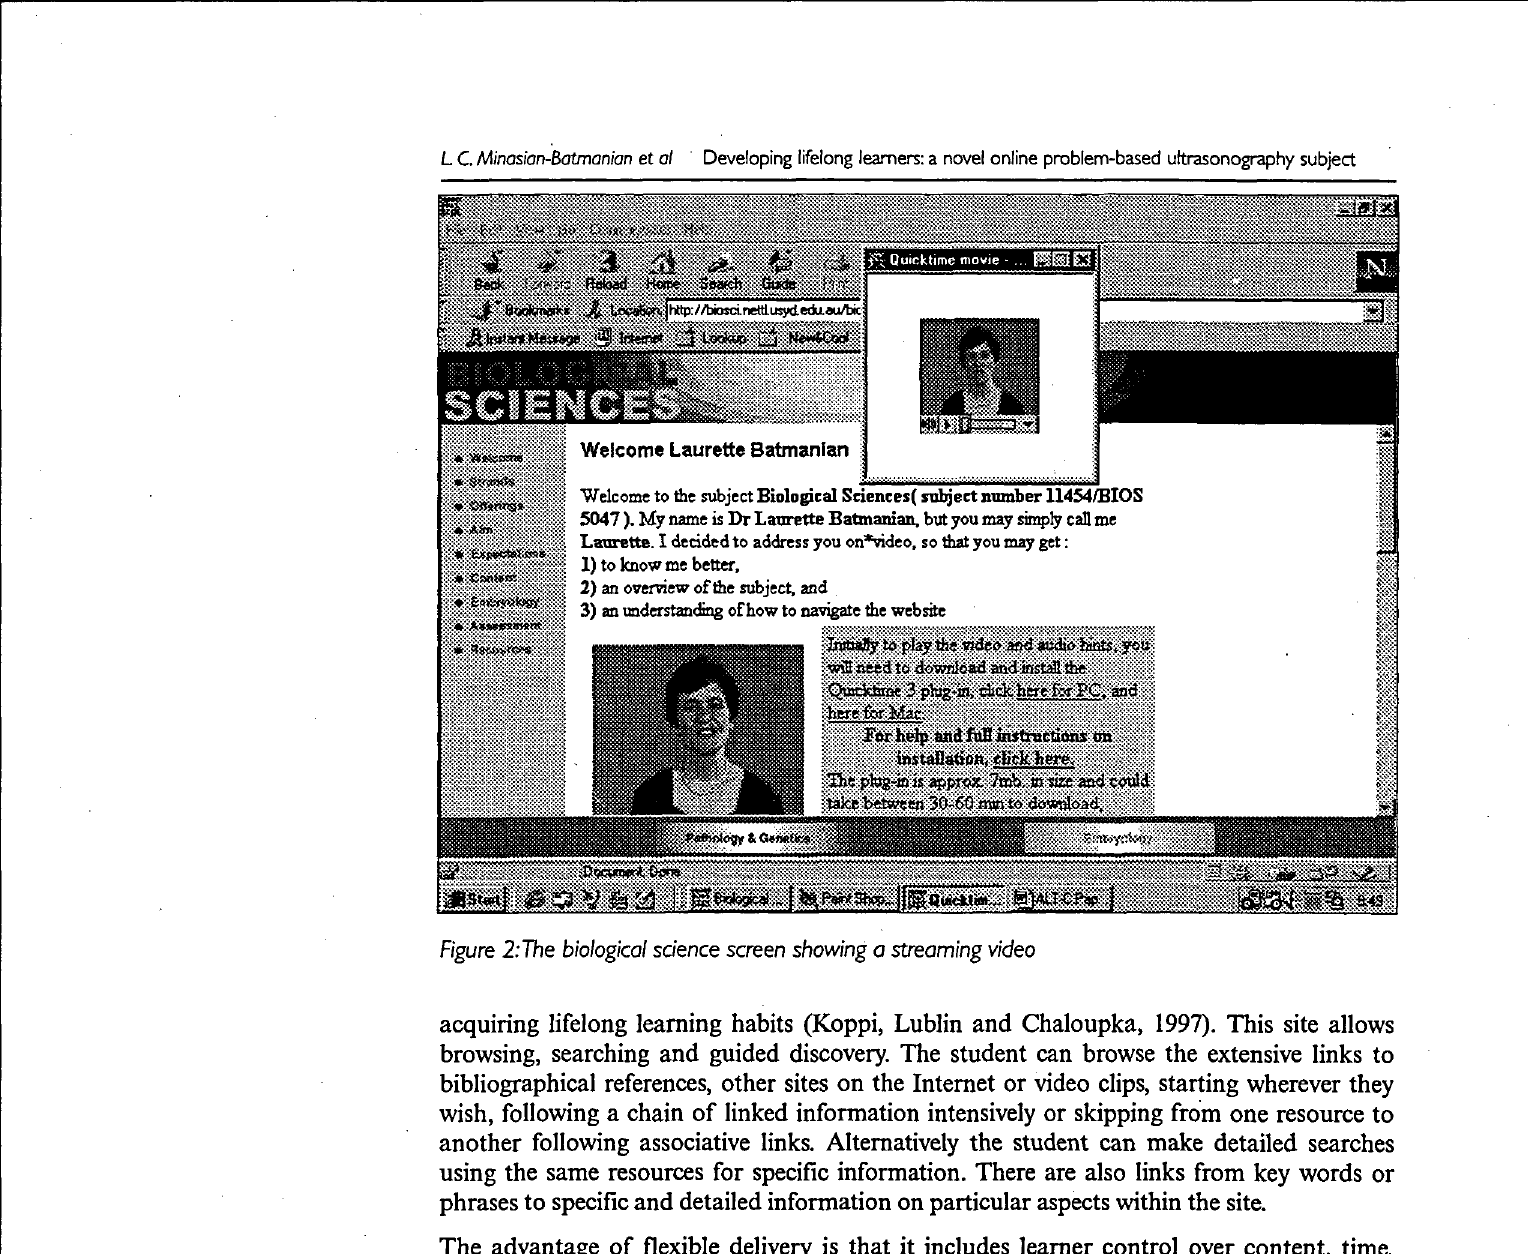
figure 2: The biological science screen showing a streaming video acquiring lifelong learning habits (Koppi, Lublin and Chaloupka, 1997). This site allows browsing, searching and guided discovery. The student can browse the extensive links to bibliographical references, other sites on the Internet or video clips, starting wherever they wish, following a chain of linked information intensively or skipping from one resource to another following associative links. Alternatively the student can make detailed searches using the same resources for specific information. There are also links from key words or phrases to specific and detailed information on particular aspects within the site. The advantage of flexible delivery is that it includes learner control over content, time, place and method of learning. Online course materials are specially designed for studying when and where the students choose. The students can phone, fax, mail, or email teaching staff whenever they need help. Frequently asked questions regarding the educational aspects of the site are answered online. A suggested timetable (Figure 4), recommended length of discussions and a study schedule have been included to give participants an estimate of the time involved in this subject and the rate at which they can expect to progress. To engage students in the learning process, a case Proforma was incorporated, which summarizes the steps in the Protocol to guide the students through the learning process. Although a comprehensive online help system is provided, a fifty-page User Site Guide is mailed to students before semester starts, to familiarize them with the learning environment and navigational